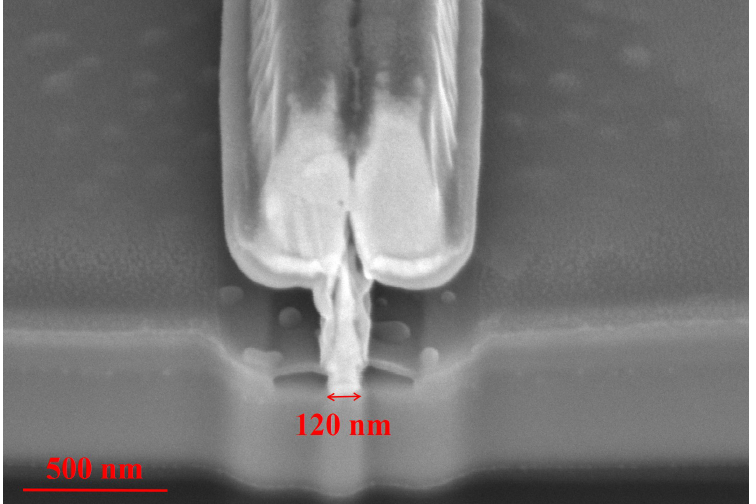
Figure 4. Cross-sectional FIB image of 120 nm T-gate.